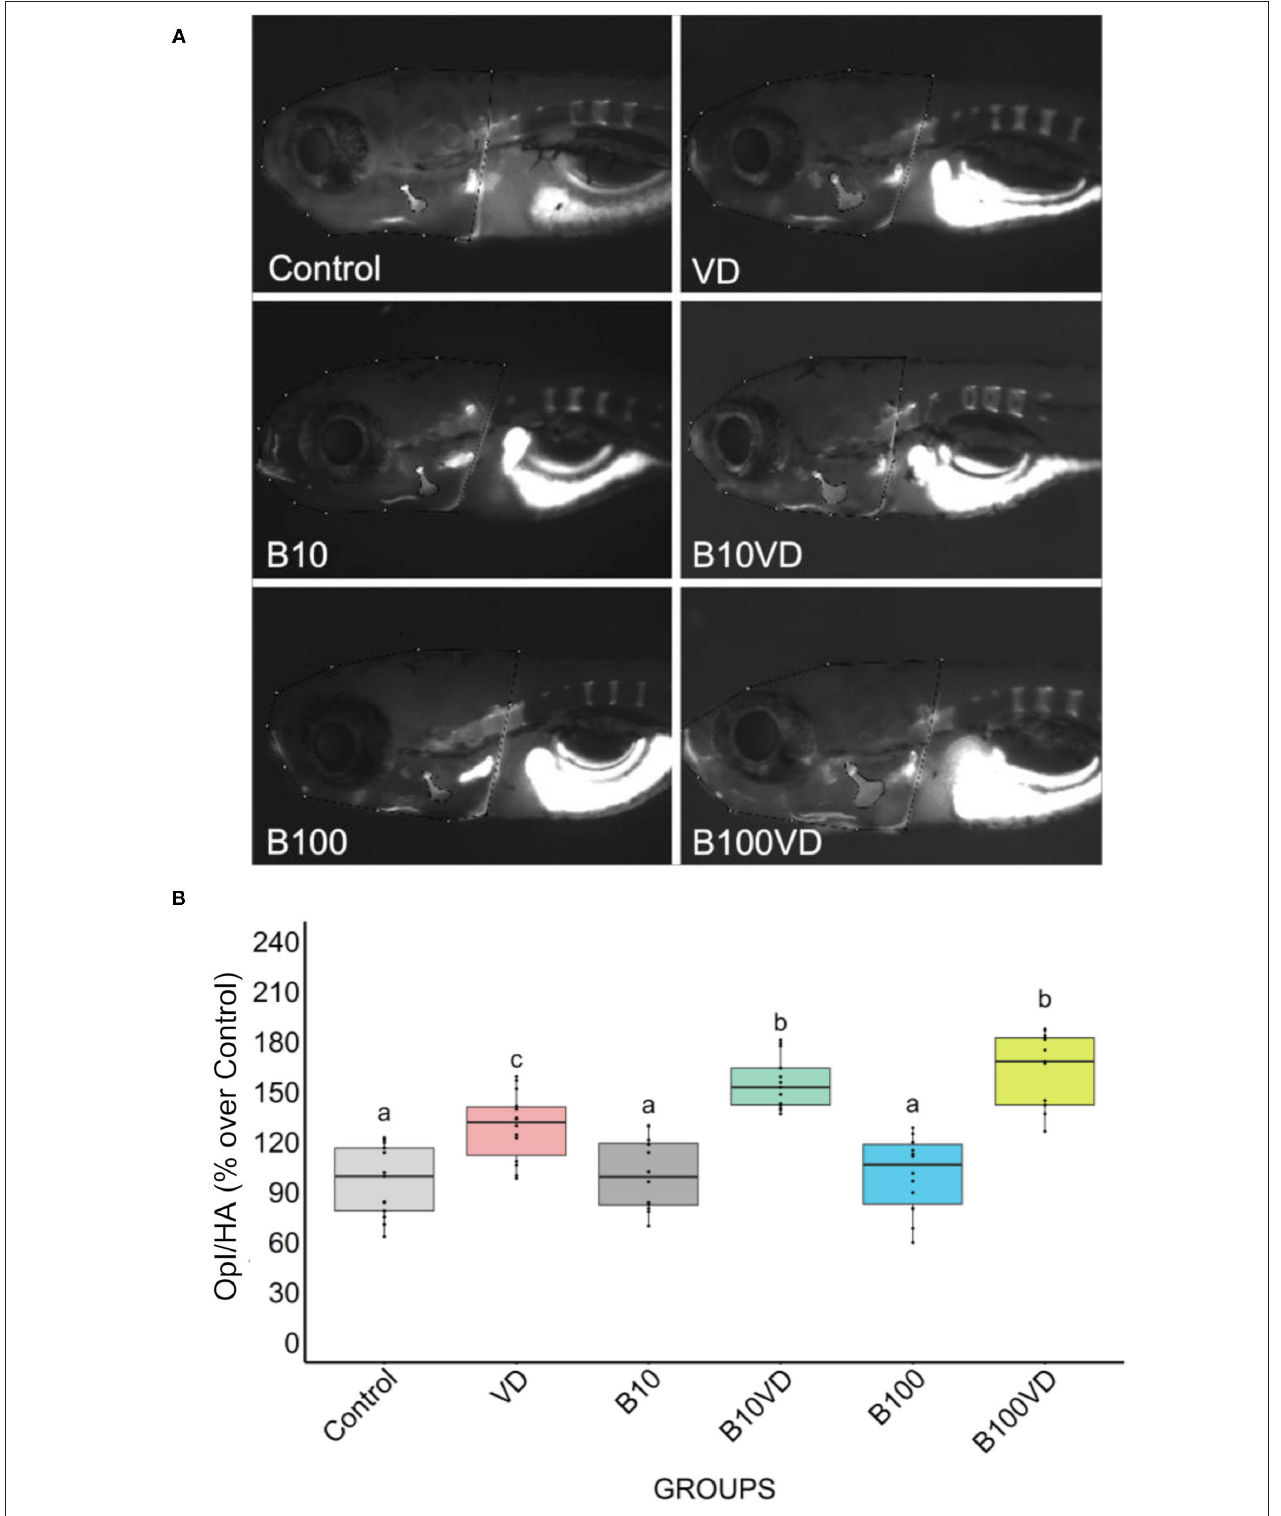
FIGURE 1 | Fluorescence microphotograph of AR-S-stained larvae and ImageJ quantification of the opercular bone mineralization. (A) Mineralized bones stained by AR-S staining at 9 dpf following different treatments. (B) Quantitative analysis of the operculum bone integrated pixel density normalized by head area (Opl/HA) showed as % over control in fish treated with different concentrations of B and VD. Different letters above each graph indicate statistically significant differences among different groups. One-way ANOVA and Tukey’s post-hoc test were used, and statistical significance was set at p < 0.05.